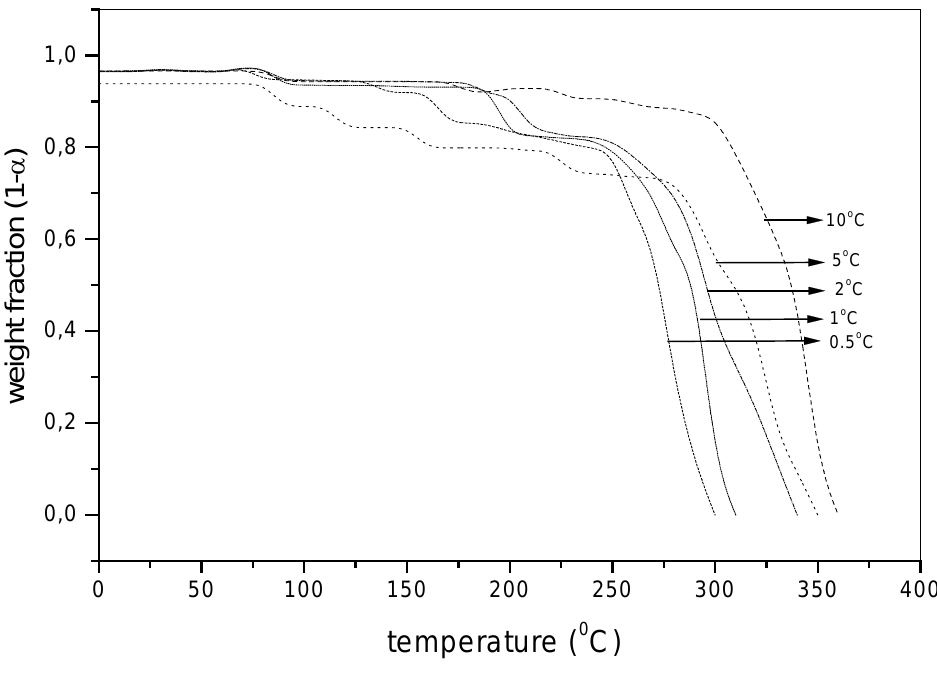
Figure 2 . The weight fraction (1- α ) of the sample aqPUR1 with the MnCAT (2%) depending on the temperature during the dynamic thermooxidation at different heating